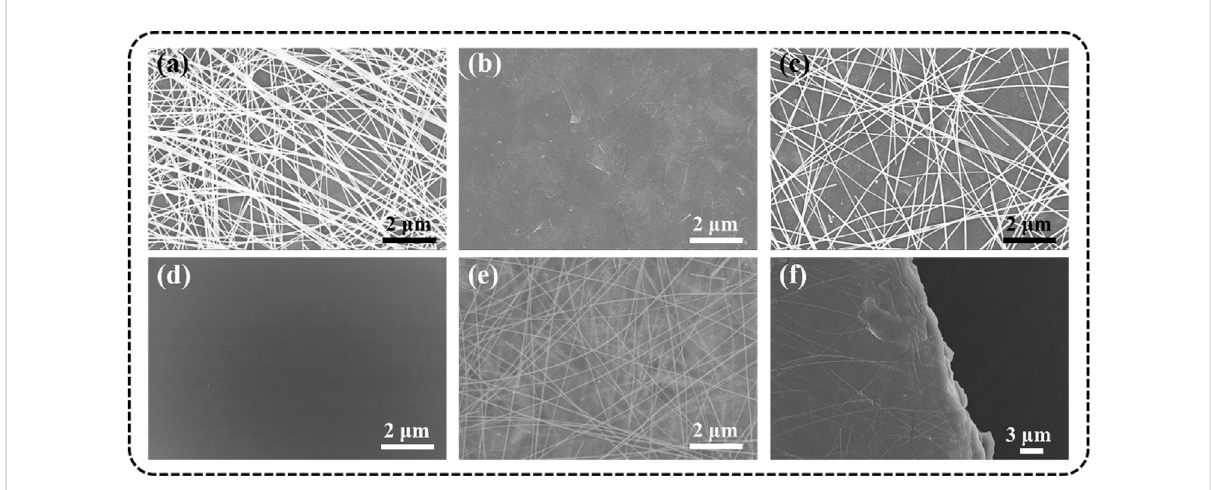
FIGURE 4 SEM images of different fi lms: (A) AgNWs-PET, (B) Ti 3 C 2 T x -PET, (C) AgNWs/Ti 3 C 2 T x -PET, (D) FG/PVA, (E) surface, and (F) pro fi le of AgNWs/ Ti 3 C 2 T x